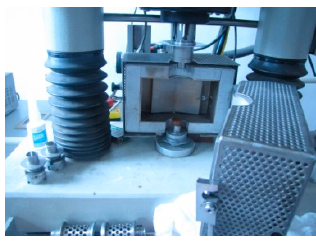
Figure 5. The ZN-1 viscoelastic material standard test piece.